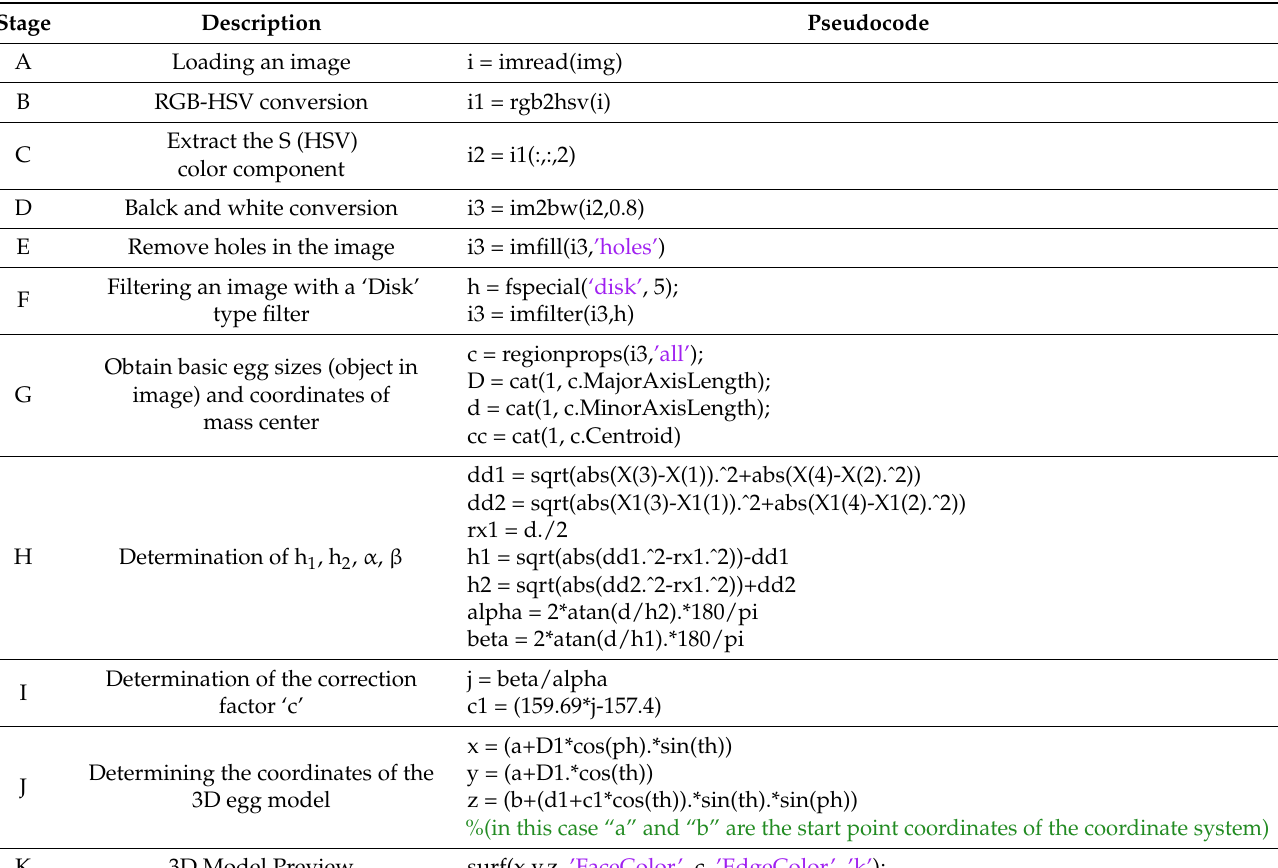
Table 1. An algorithm for obtaining 3D model of eggs by visual